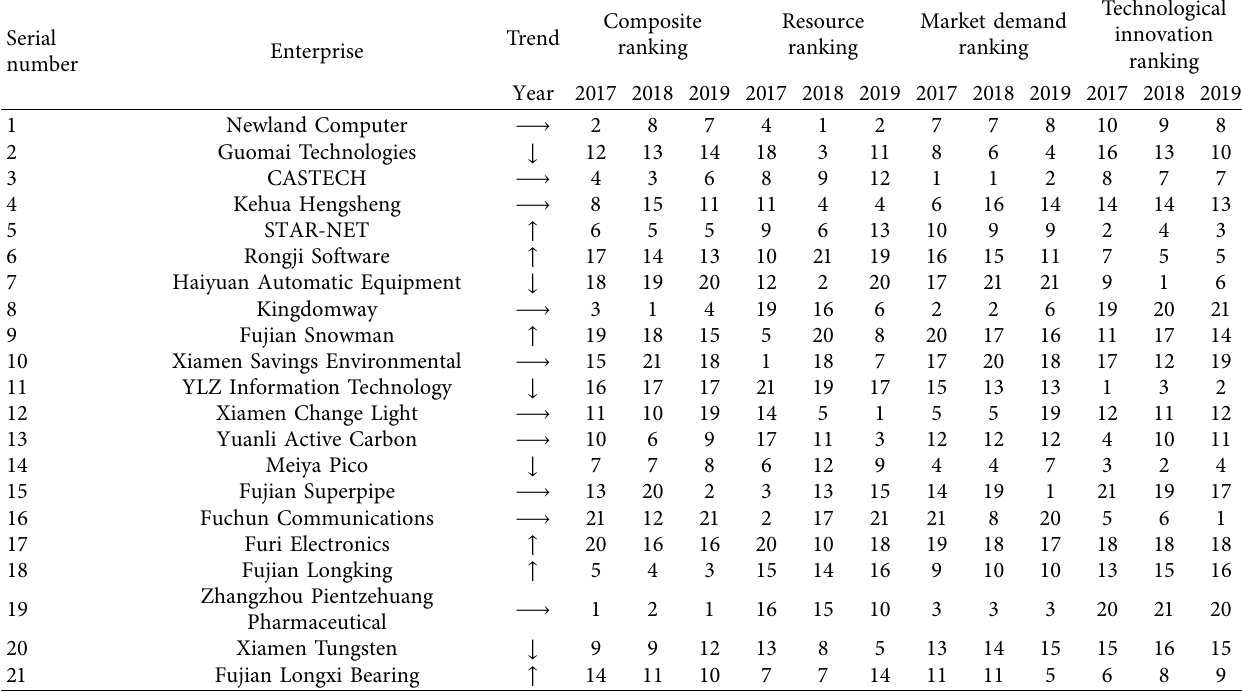
Table 3: Trend of VIKOR composite index of each backbone enterprise